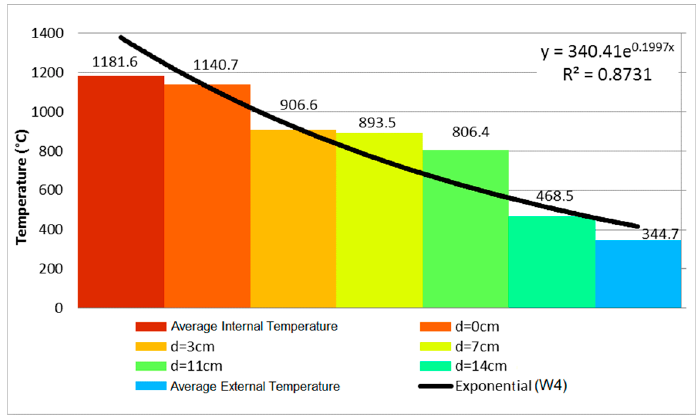
Figure 14. Temperature profile at 240 min—W4.